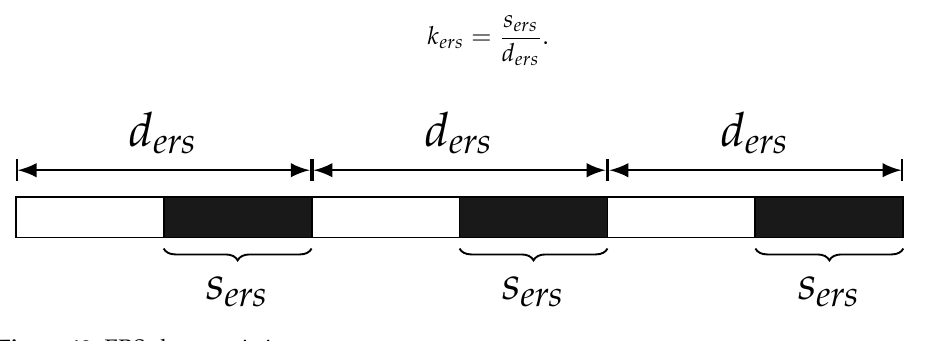
Figure 12. ERS characteristics.